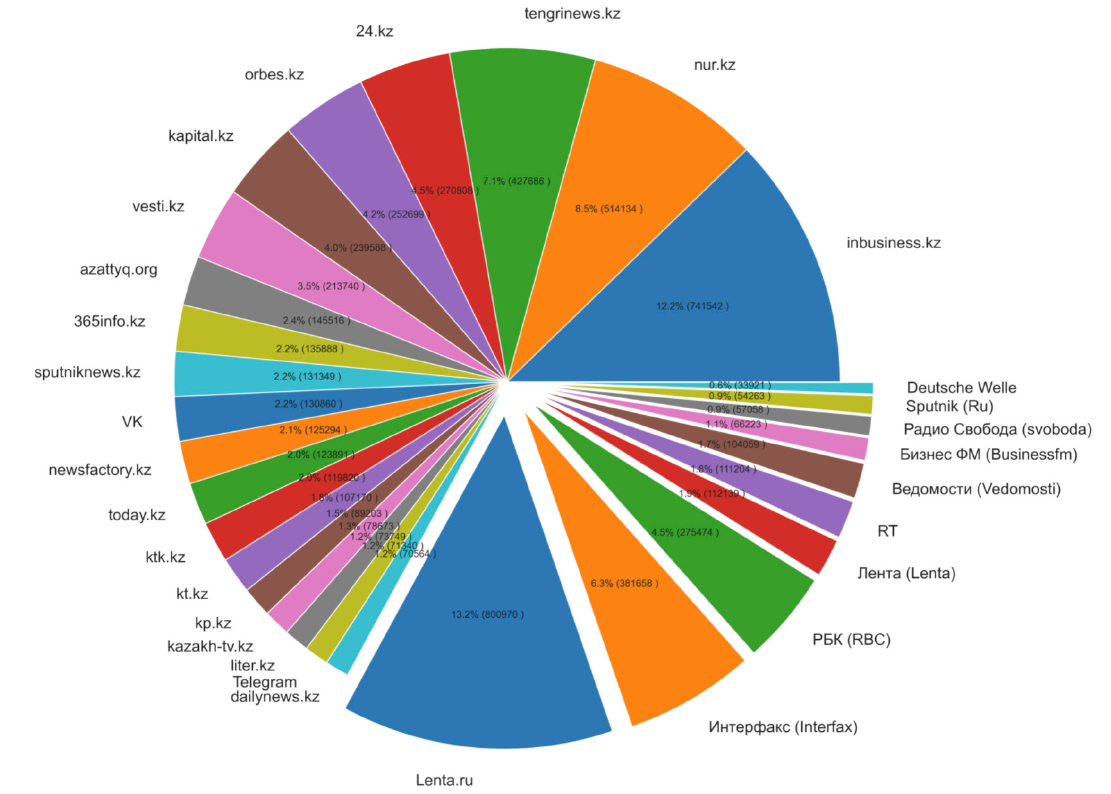
Figure 2. Major sources of the corpus.